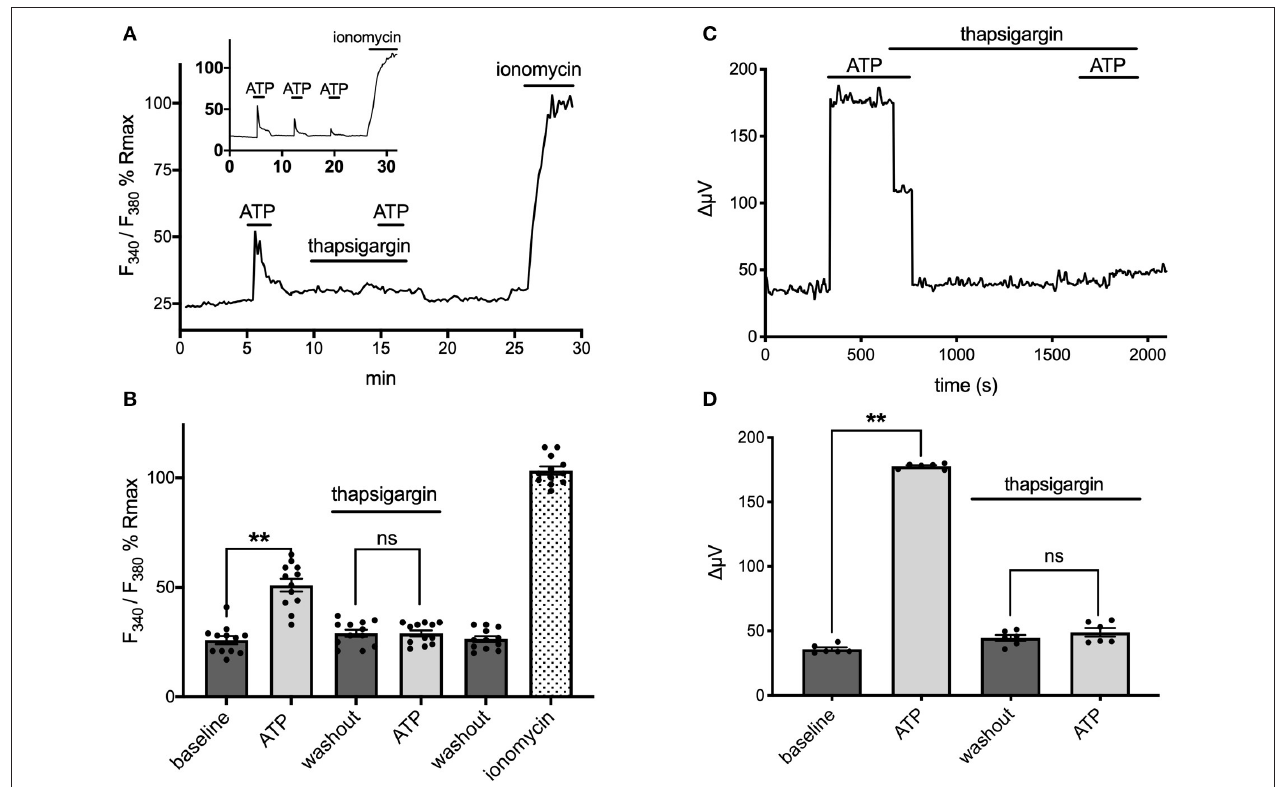
FIGURE 6 | ATP-induced alterations in H + flux require increases in intracellular calcium. (A) Measurements of changes in intracellular calcium from cells cultured from mouse hippocampus as reported by the calcium indicator fura-2. Trace shows averaged percentage change in the ratio of Fura-2 fluorescence from 12 astrocytes imaged simultaneously plotted as a percentage of the maximal change in ratio observed upon addition of the calcium ionophore ionomysin. Challenge of the cells with 100 µ M ATP resulted in an increase in the ratio of Fura-2 fluorescence indicative of an increase in intracellular calcium. Following washout of the ATP and return of the signal to baseline, cells were superfused with 1 µ M thapsigargin for several minutes and then challenged a second time with 100 µ M ATP, which now induced little change in the Fura-2 ratio. The thapsigargin and ATP were then removed from the dish; after several additional minutes, the calcium ionophore ionomycin was added to determine a maximal change in fluorescent ratio. Inset shows typical response to multiple applications of ATP under control conditions with no thapsigargin present. (B) Data from the same cells presented in histogram format, again as a percentage of the maximal induced change in ratio induced by application of ionomycin; N = 12. (C) Self-referencing trace from a single cell cultured from cryopreserved mouse hippocampal cells showing alteration in H + flux to 100 µ M ATP. The cell was then bathed in 1 µ M thapsigargin, ATP washed off, and the cell left to sit in thapsigargin for several minutes. A second application of 100 µ M ATP now produced little change in the H + flux signal. (D) Effects of thapsigargin on H + flux signal; N = 6. **indicates P < 0.01; ns indicates not significantly different ( P >